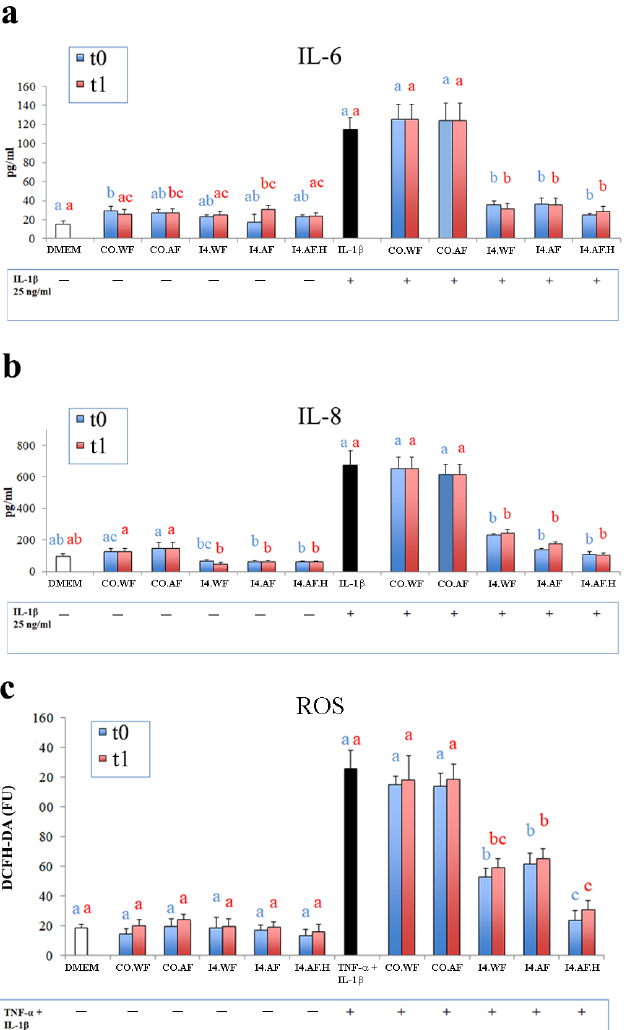
Figure 7. IL-6 ( a ), IL-8 ( b ), and intracellular ROS ( c ) measured at 24 h in Caco-2 cells after exposure to lyophilized ice creams (100 mg/mL) both fresh (t0) and after one month of storage at − 20 °C (t1). +, Caco-2 cells were also stimulated with IL-1 β (25 ng/mL) for IL-6 and IL-8 release and with TNF- α (2 ng/mL) and IL-1 β (25 ng/mL) for ROS induction. CO.AF and CO.WF represent Caco-2 cells treated with no fermented ice creams, respectively, with and without the addition of dietary fibers. I4.AF and I4.WF are Caco-2 cells treated with fermented ice creams, with and without the addition of dietary fibers, respectively. I4.AF.H represents the Caco-2 cells treated with fermented ice cream with the addition of both dietary fibers and HT. DMEM alone was used as the negative control. DMEM containing the corresponding stimulus was used as the positive control. Data are the means ( ± SD) of three biological replicates analyzed in triplicate. One-way ANOVA and individual post hoc comparisons with the Tukey–Kramer was performed separately for t0 and t1. Different analyses display superscript letters with different colors. For every analysis, values with different superscript letters differ significantly ( p <